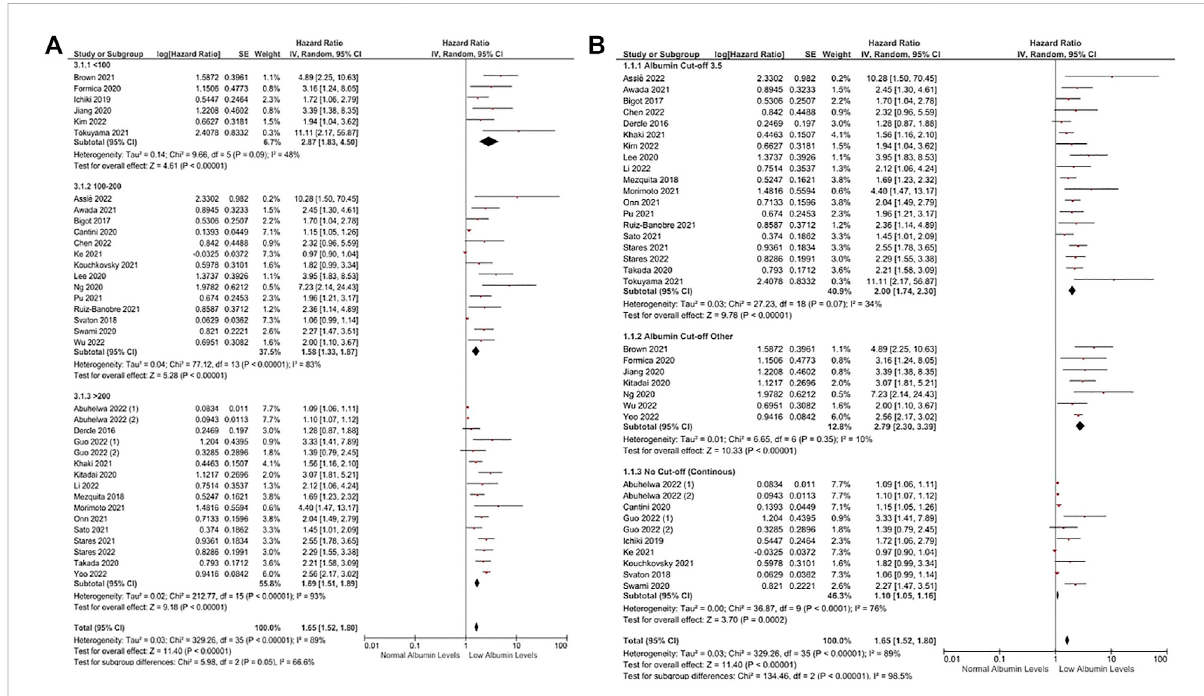
FIGURE 3 Subgroup analyses according to sample size (A) and albumin cut-offs (B) in OS. Lines ( ○ ) indicate 95% CIs. Diamond ( ◆ ) indicates the pooled effect